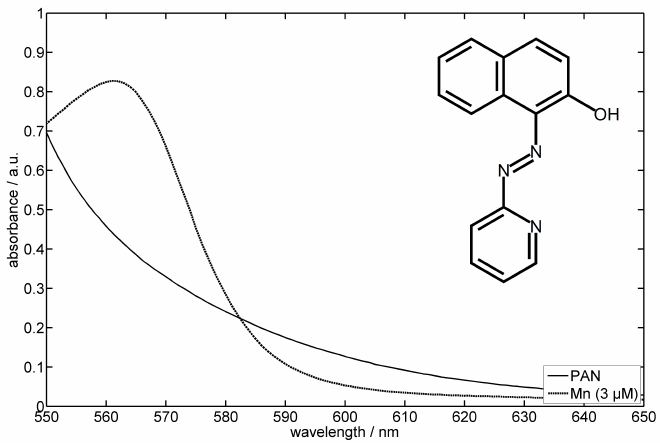
Figure 3. Molecular structure of 1-(2-pyridylazo)-2-naphthol (PAN) as well as absorption spectra of